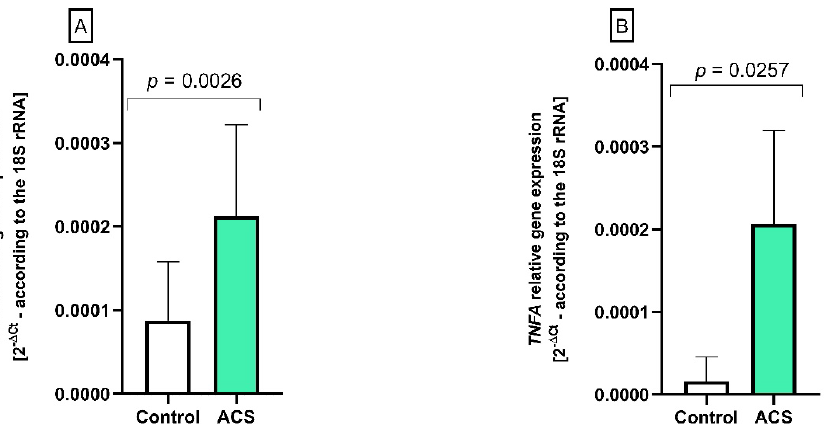
Figure 3. The altered expression of ( A ) IL1B and ( B ) TNFA genes in the peripheral blood cells from patients with ACS compared to healthy subjects. The results from gene expression are presented as a mean of 2 − ∆ Ct (according to the gene encoding 18S rRNA) ± SD, n = 12. Statistical analysis was performed using Student’s t -test.